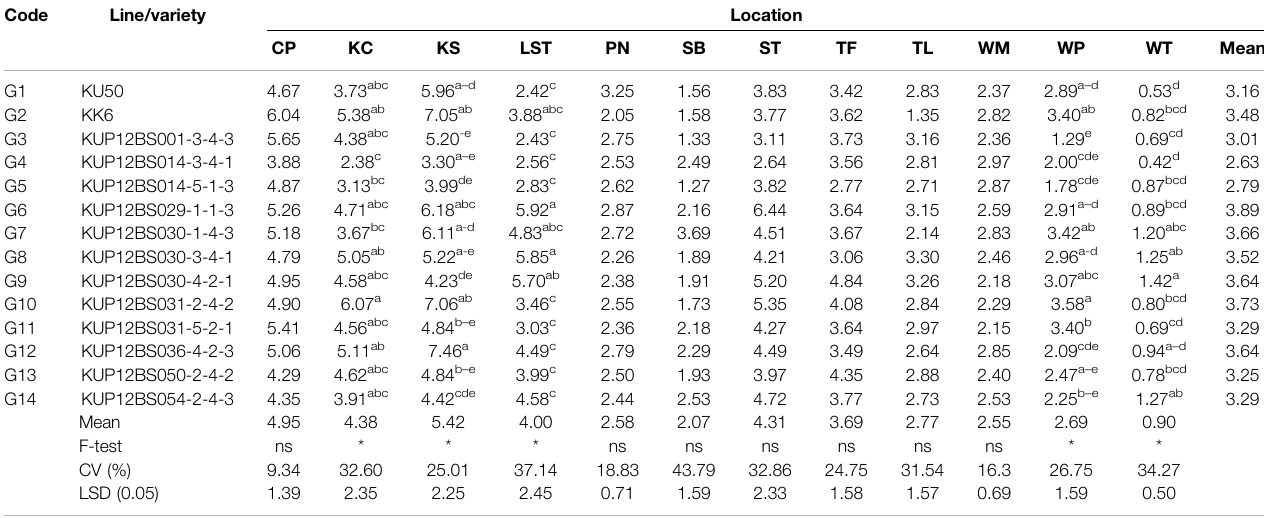
TABLE 4 | Pod yield (t · ha − 1 ) of 12 peanut lines and 2 check varieties planted in 12 locations. Code Line/variety Location